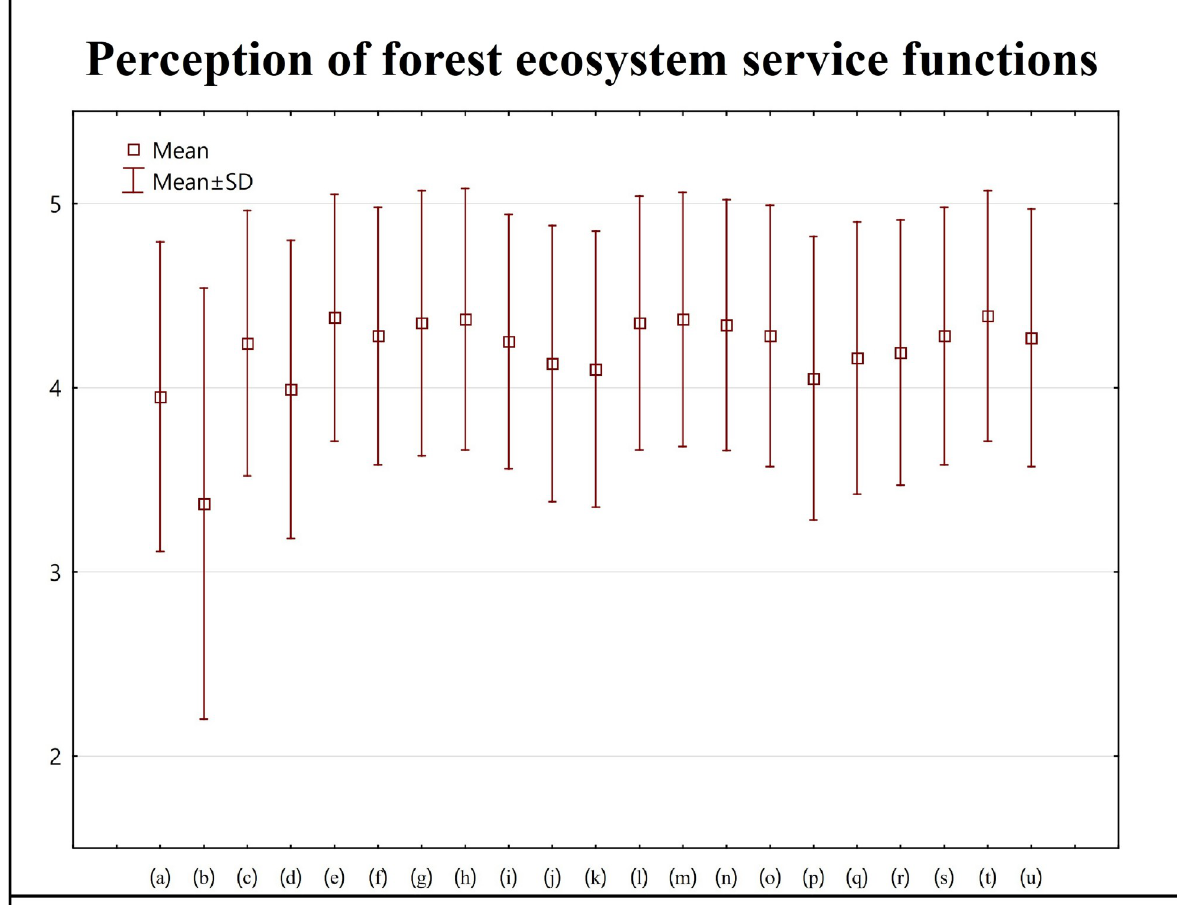
Fig 2. Results of the analysis of the perceptions of forest ecosystem service functions by tourists to the Guanwu National Forest Recreation Area in Taiwan.